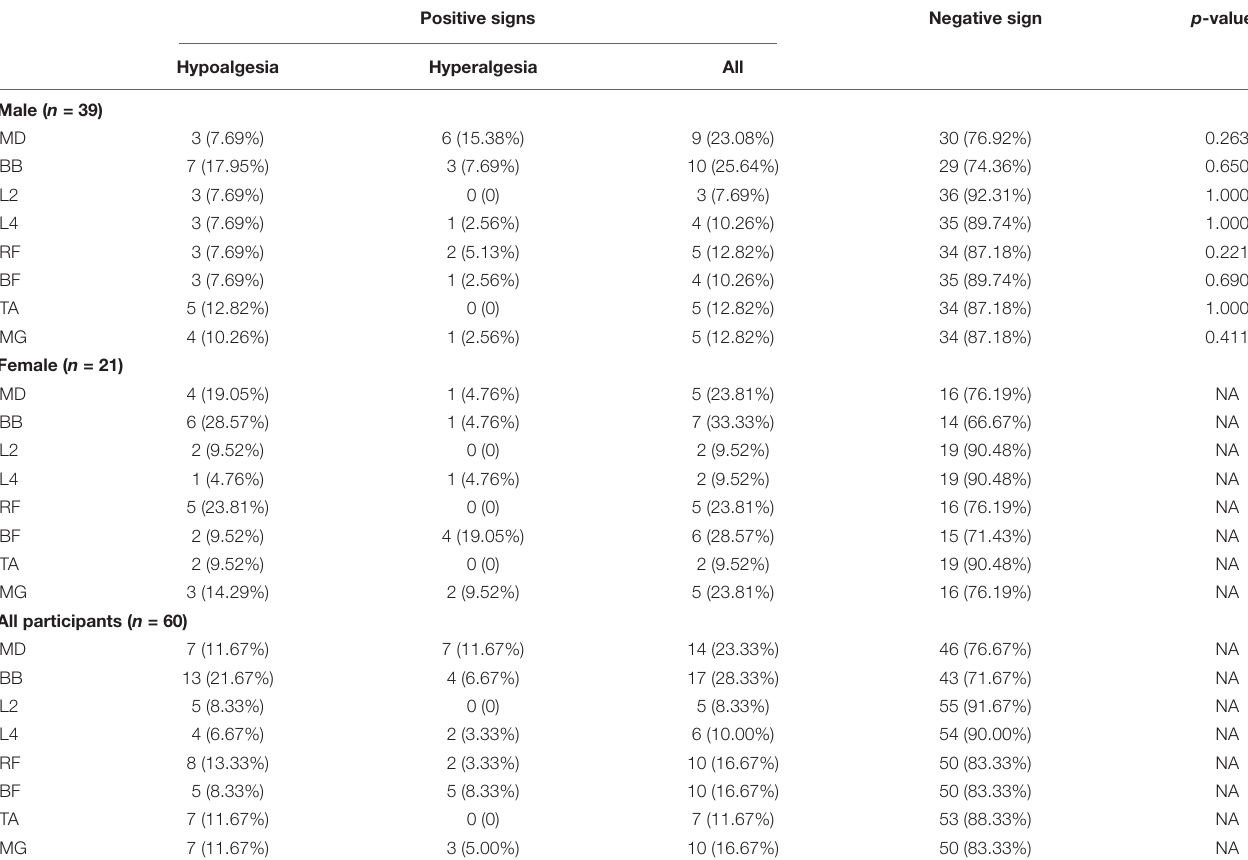
TABLE 3 | Somatosensory signs for pressure stimuli (n,%). Positive signs Negative